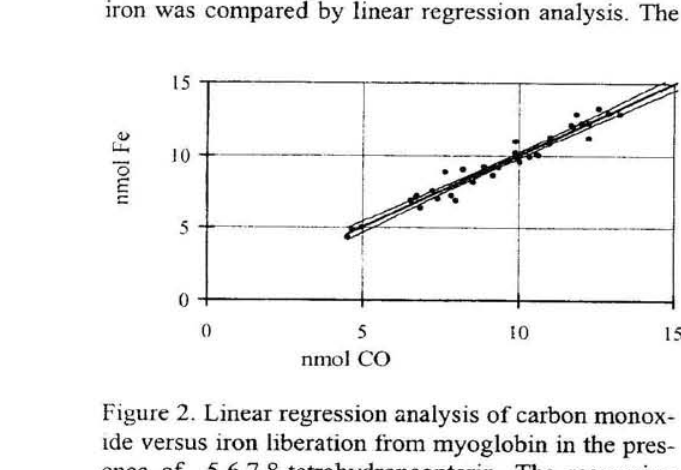
Figure 2. Linear regression analysis of carbon monox- ide versus iron liberation from myoglobin in the pres- ence of 5,6,7,8-tetrahydroneopterin. The regression line is shown with the 95% confidence